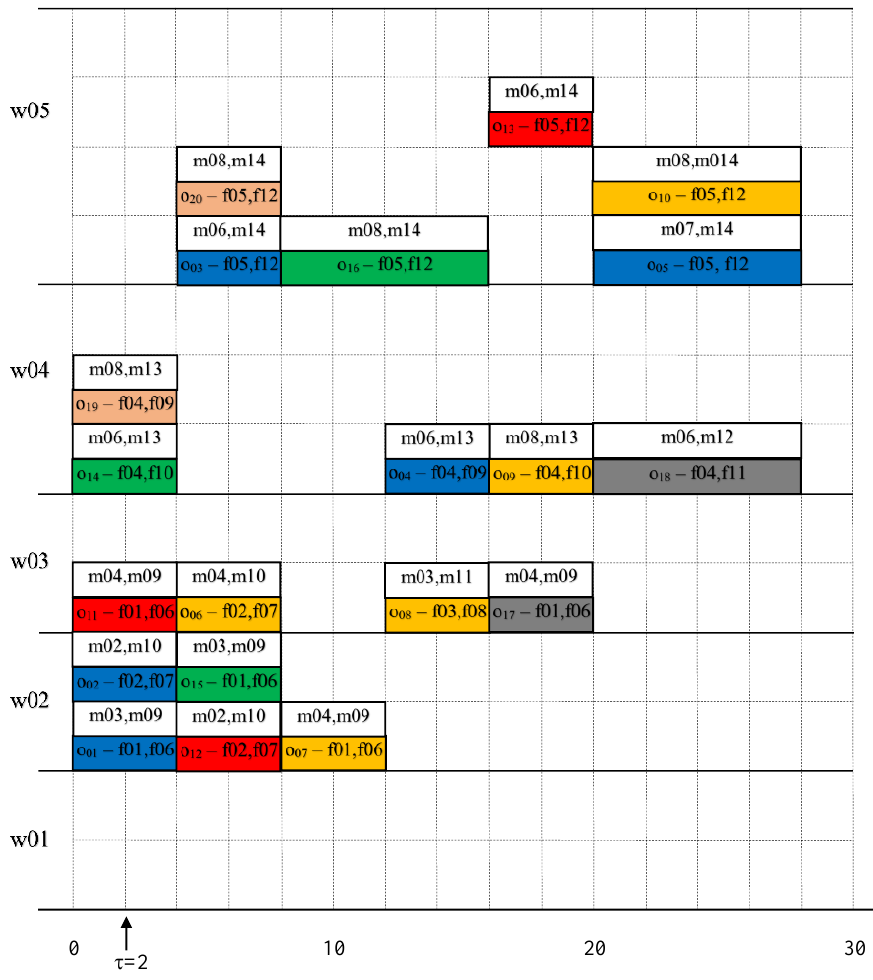
Figure 9. Project implementation schedule with the assignment of tasks and multidimensional resources to workstations for Q_4 (individual projects have different colors as shown in Figure 5).